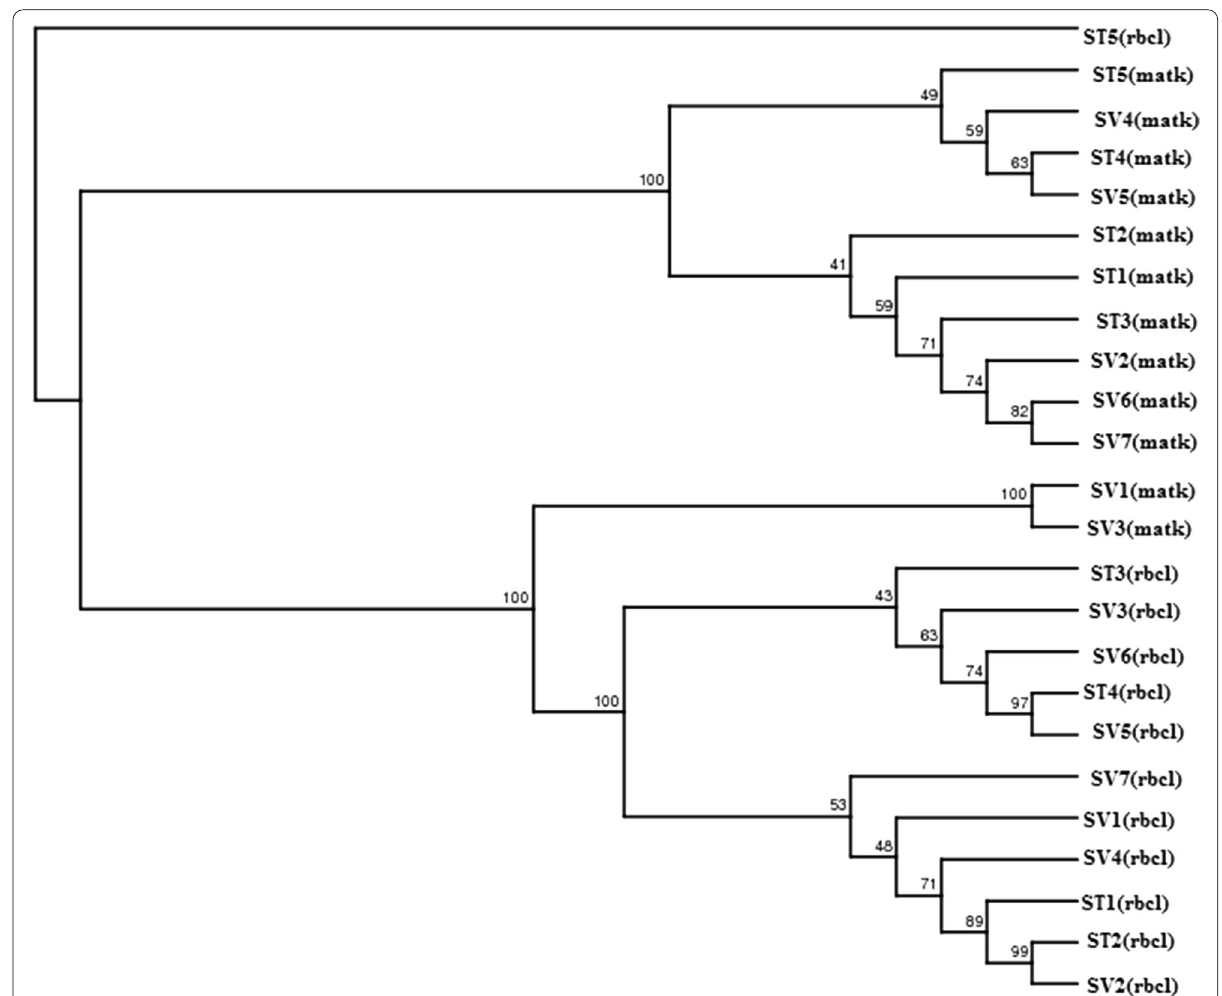
Fig. 3 Comparative analysis of 12 different accessions of Selinum from matK and rbcL